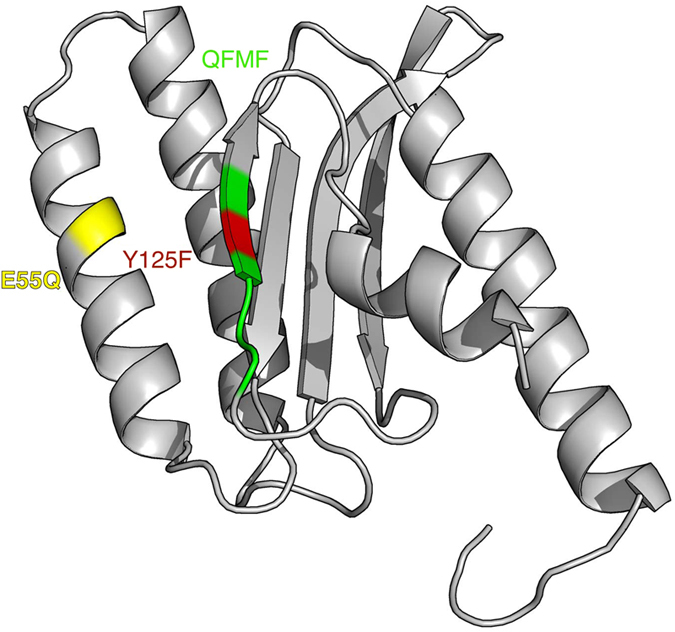
Activity associated mutations introduced in N-domain of eRF1.The E55Q mutation is colored yellow and believed to abolish hydrogen bonds with Y125F colored in red. The unipotent-associated mutation, Q122FM_F126 is colored in green. The coordinates for the N-domain are derived from crystallographic data10.